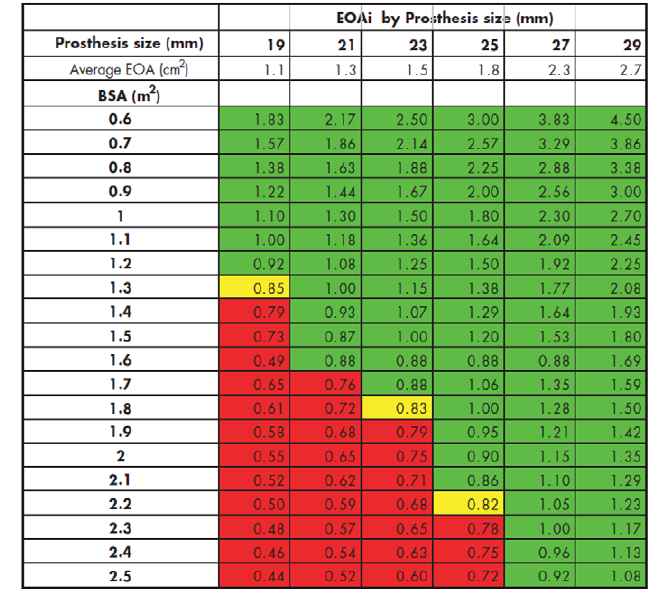
Figure. 14 Comparison of the changes in transvalvular gradient during follow-up in patients with pulmonary autograft versus those with aortic homograft. The transvalvular gradient falls down to an average value of 5 mmHgafteroperationandremainsstableduringthewholefollow-upinthepulmonaryautograftgroup,whereas it progressively increases in the aortic homograft group. (Reproduced with permission from